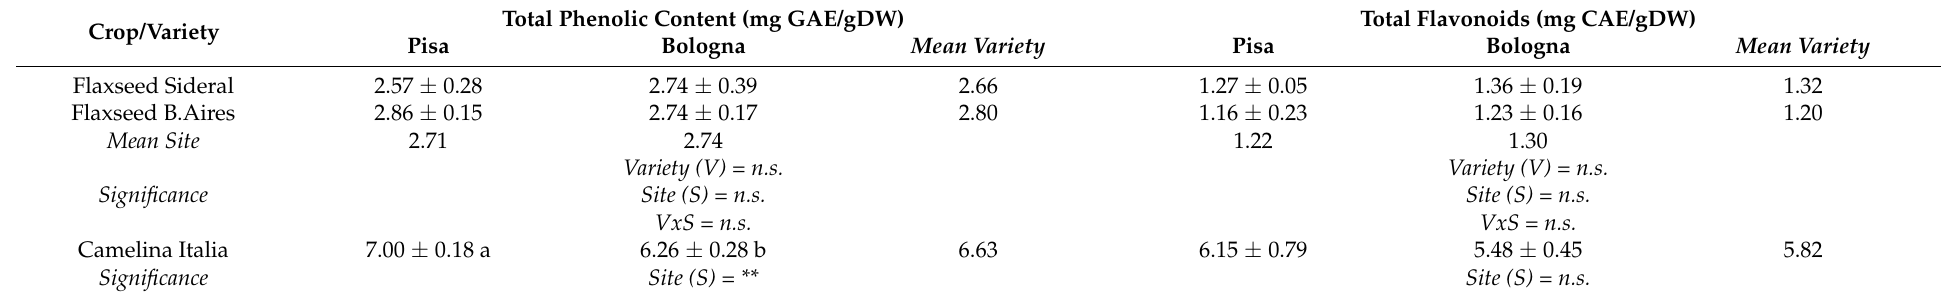
Table 1. Total phenols and total flavonoids (mean † ± SD) in the defatted seed meal of flaxseed (Sideral and Buenos Aires) and camelina (Italia) from two cultivation sites (Pisa and Bologna).